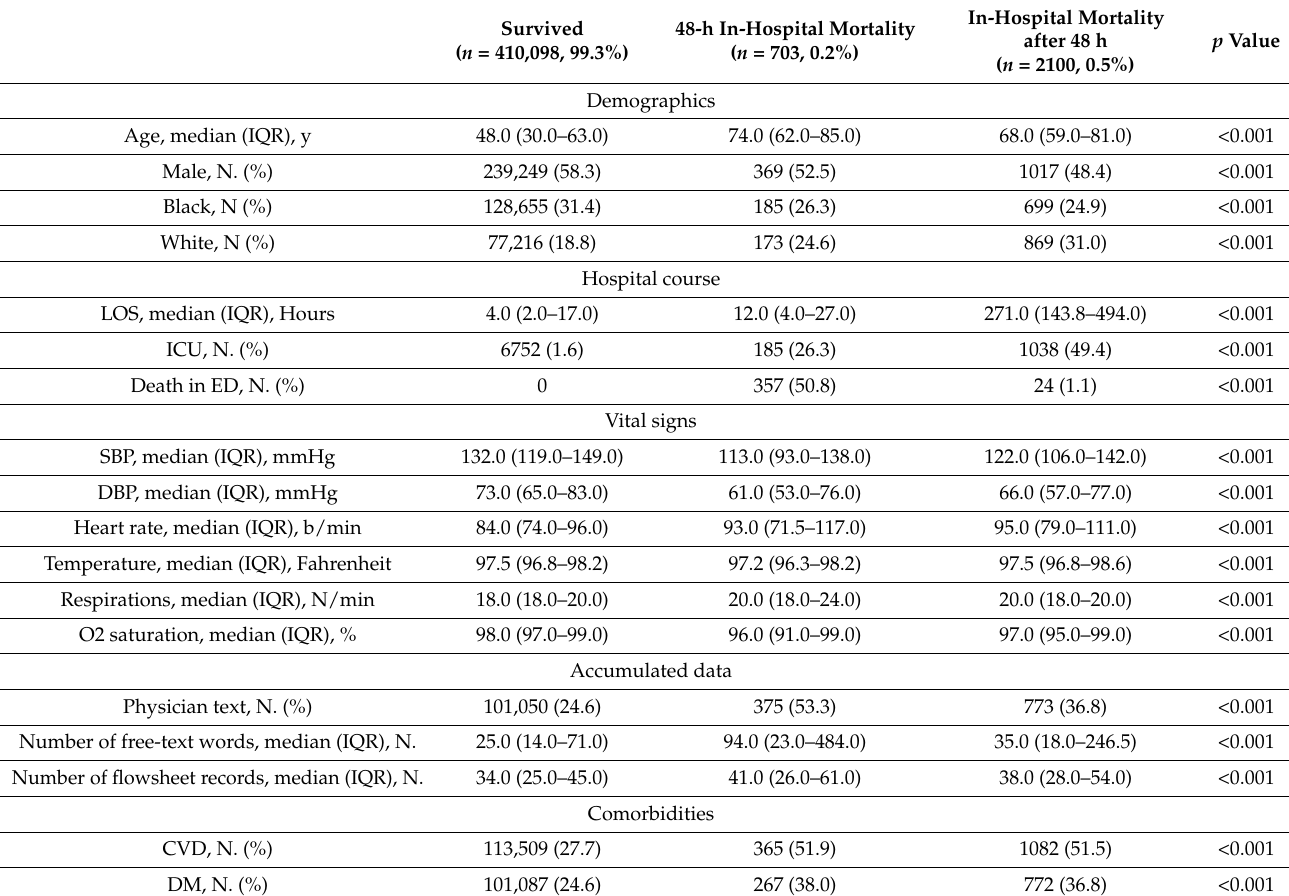
Figure 2. Inclusion flow chart. Patient characteristics of both the training and testing dataset are presented in Table 1. Significant differences were observed between patients who died and those who survived (Table 1). Of note, about half of the mortality cases had known cardiovascular and onco- logical diseases. Table 2 describes how the data were distributed across the training and testing datasets. Table 1. Patients’